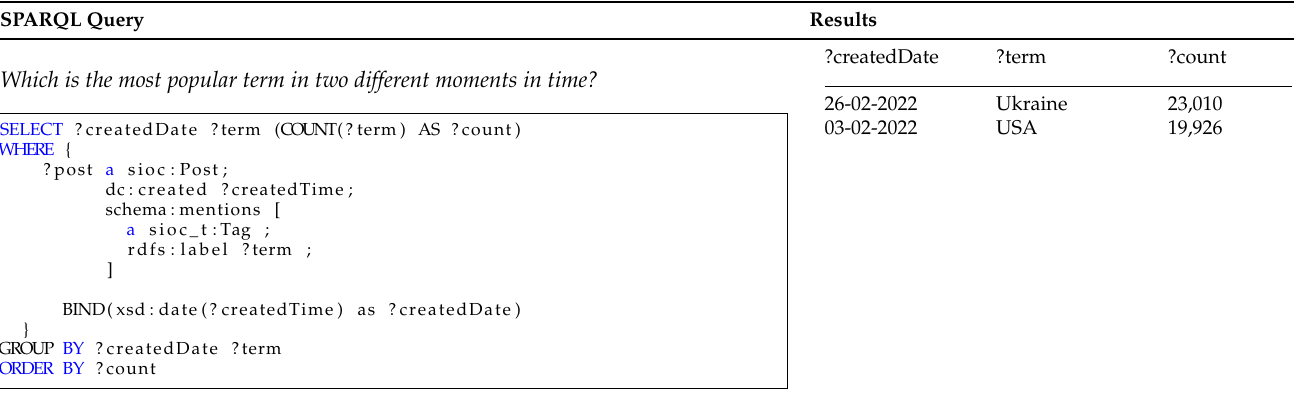
Table 4. Competency question—Q1.